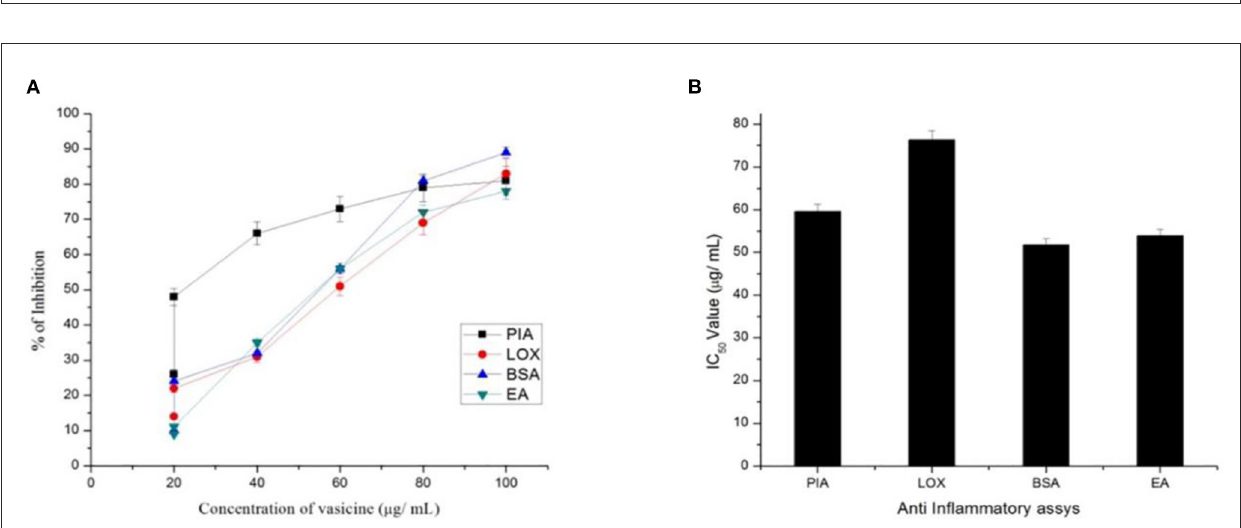
FIGURE5 (A) Percentage inhibition and (B) IC 50 value of vasicine in proteinase inhibitory activity (PIA), lipooxygenase inhibition assay (LOX), BSA using method (BSA), egg albumin method